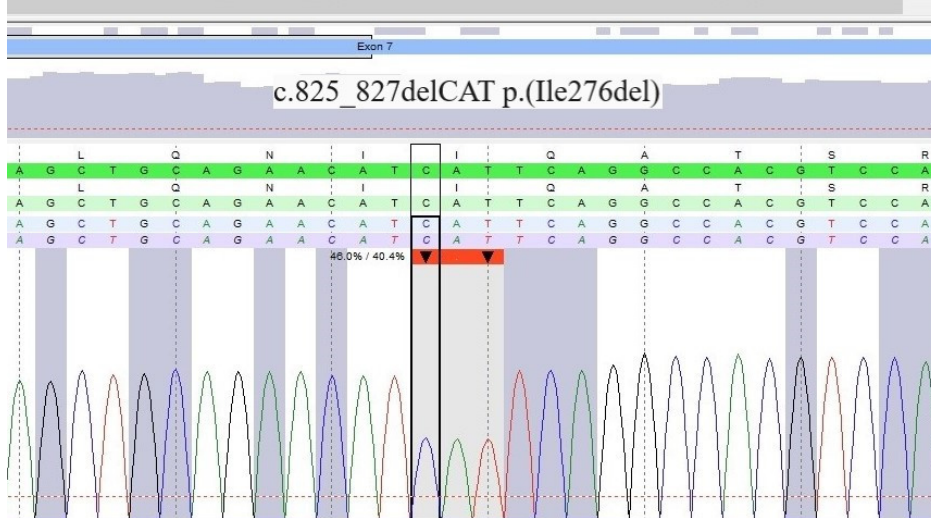
Figure 5. Result of DNA sequencing of the desmoplakin gene.